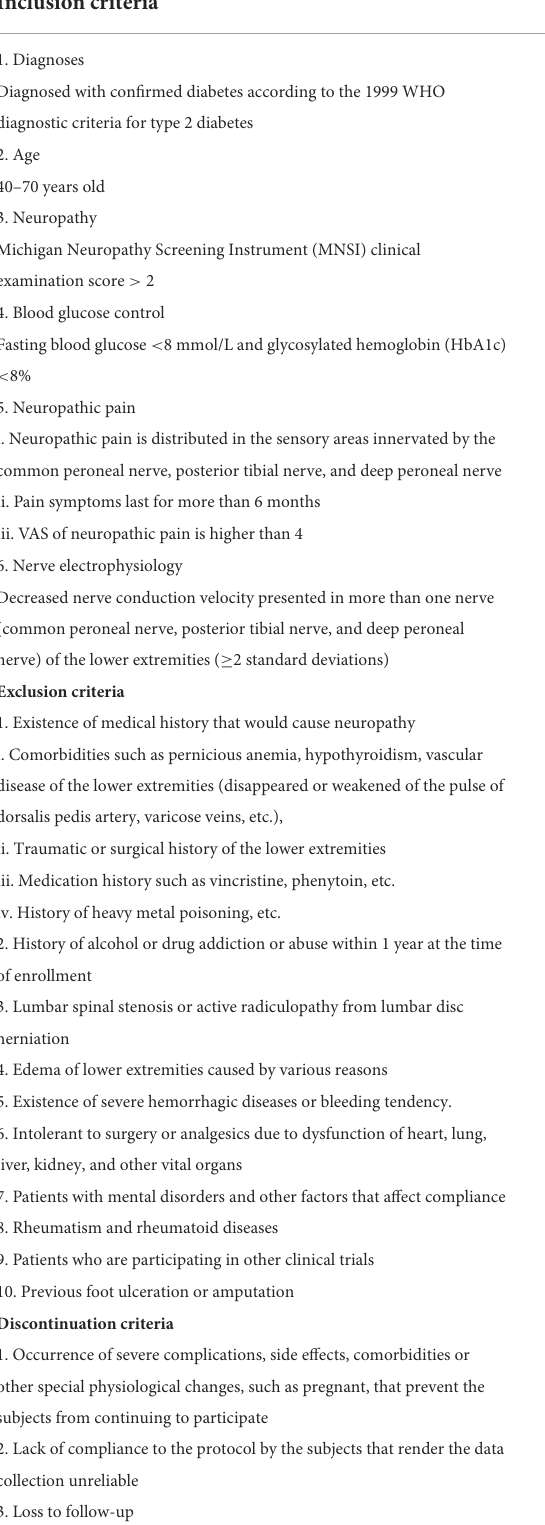
TABLE 1 The criteria for inclusion, exclusion, and